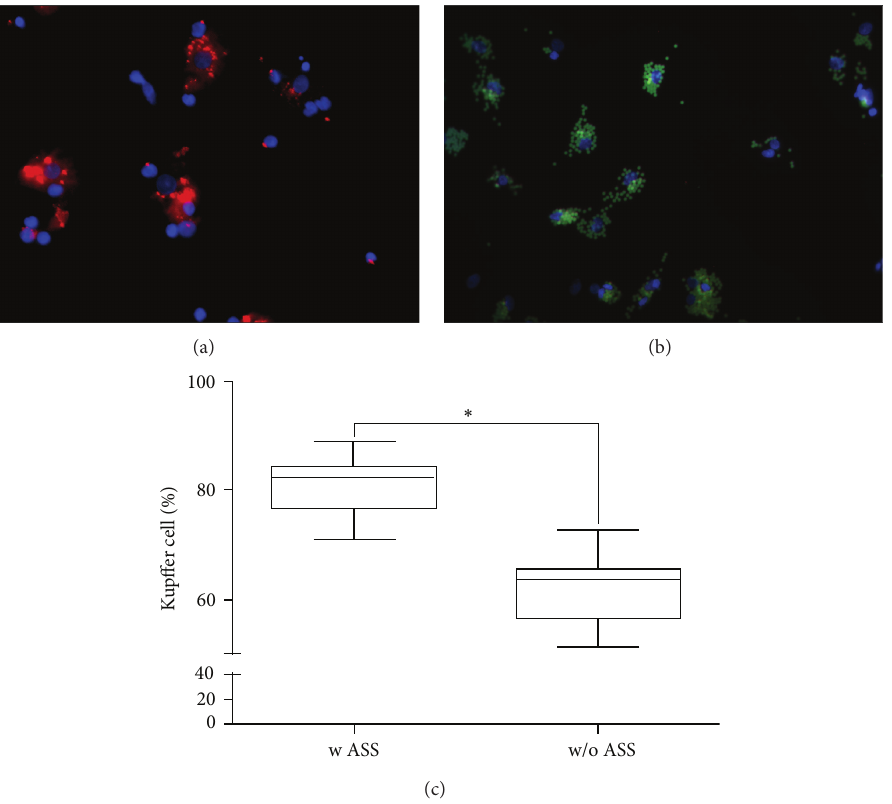
Figure 1: Identification of KC and determination of the purity of KC cultures . KC were identified by IF staining for CD68 (a) and the phagocytosis of fluorescent latex beads (b). The percentages of CD68-positive and phagocytosis-positive cells isolated with an adherence separation step (w ASS) or without an adherence separation step (w/o ASS) are shown in (c). Data are shown as box plots, representing the median, the interquartile range, and minimum and maximum values. ∗ At least 𝑃 ≤ 0.0001 (unpaired 𝑡 -test), 𝑁 = 3 , 𝑛 = 9